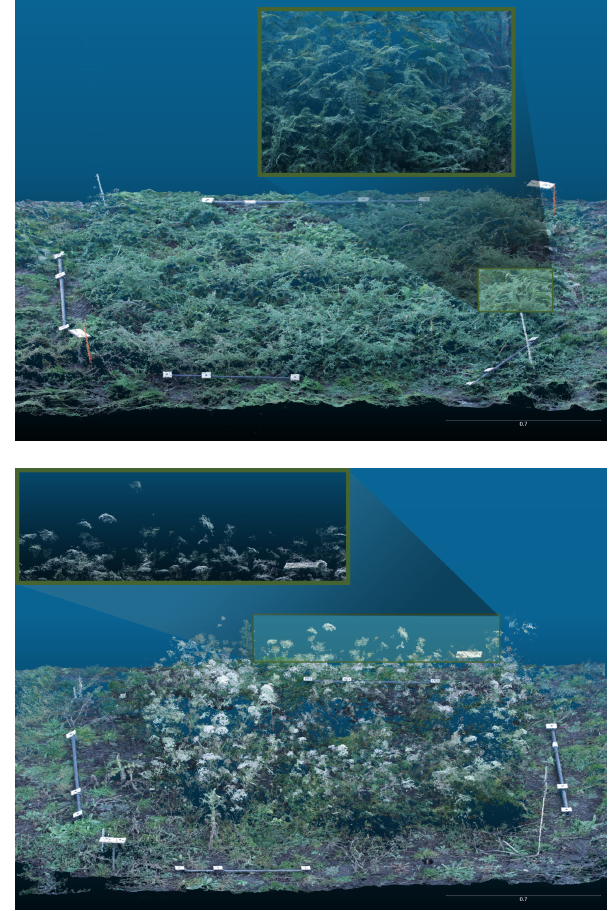
Figure 5. Generated 3D representations of Onobrychis viciifolia and Daucus carota using